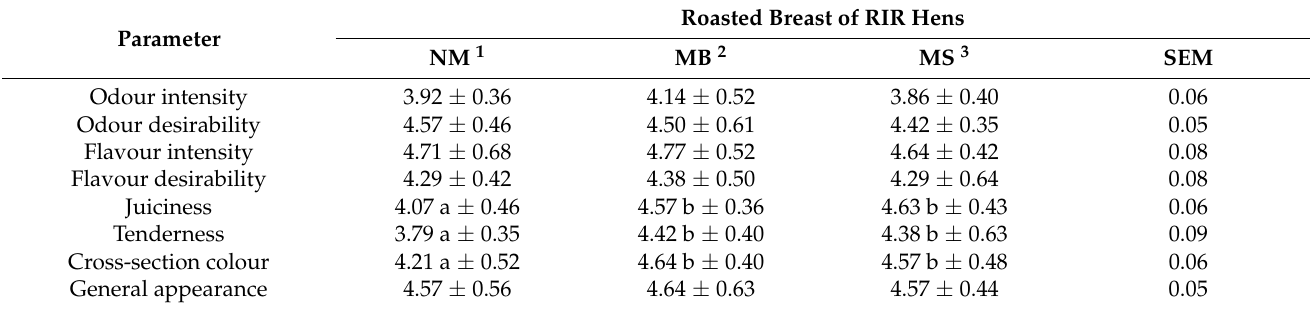
Table 4. Sensory traits of roasted breast meat, marinated and non-marinated with fermented milk products. Roasted Breast of RIR Hens Parameter NM 1 MB 2 Odour